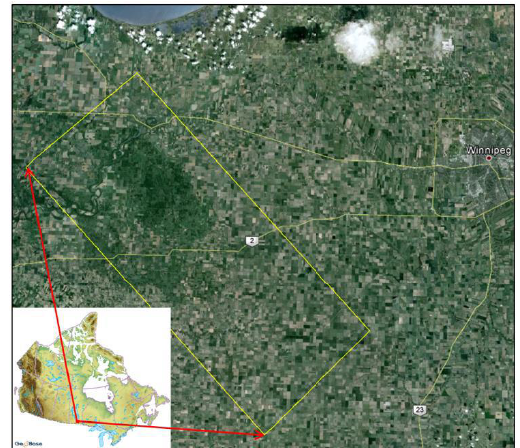
Figure 1. Location of study site Winnipeg in southern Manitoba, Canada (Geobase.ca © and Google Earth ©)